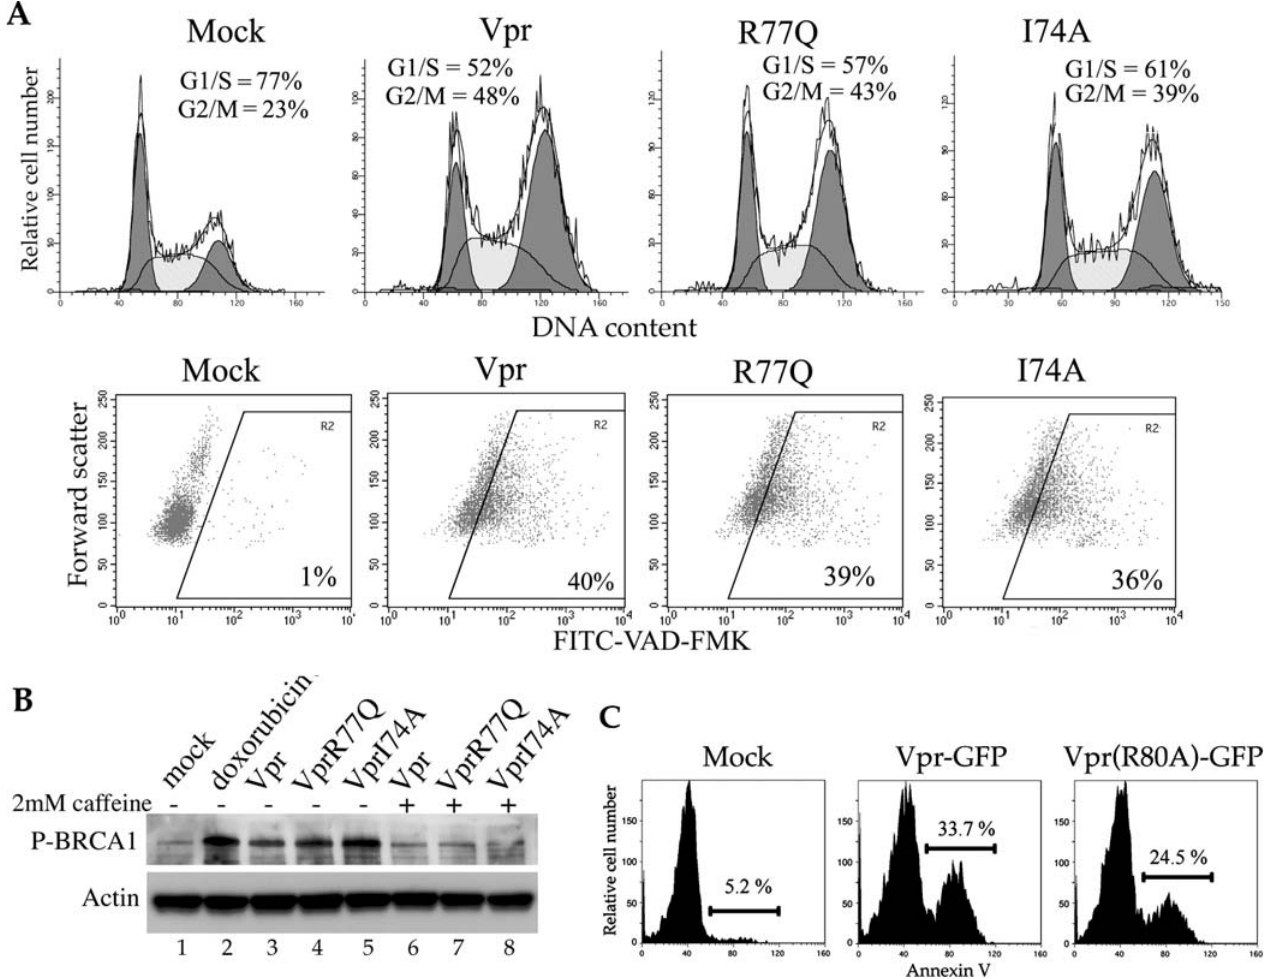
Figure 6. Functional Analysis of Vpr Mutants (A) SupT1 cells were infected with pHR-VPR-R or indicated mutants, at an MOI of 0.5. At 48 h postinfection, cells were stained with hypotonic PI to determine the cell cycle profiles. At 72 h postinfection, cells were incubated with FITC-VAD-FMK and analyzed by flow cytometry to determine the percentage of cells with active caspases. (B) Cells from above treatments were lysed at 48 h postinfection, and Western blot was performed to assay for phosphorylation of BRCA1 at Ser1423 by the ATR kinase. To establish the role of ATR in BRCA1 phosphorylation, parallel infections were treated with caffeine (2 mM). (C) Induction of apoptosis by Vpr-GFP and Vpr(R80A)-GFP fusion proteins. HPB-ALL cells were transfected with indicated constructs or mock-transfected and 48 after transfection, phosphatidylserine exposure was analyzed by flow cytometry using phycoerythrin-conjugated annexin V.